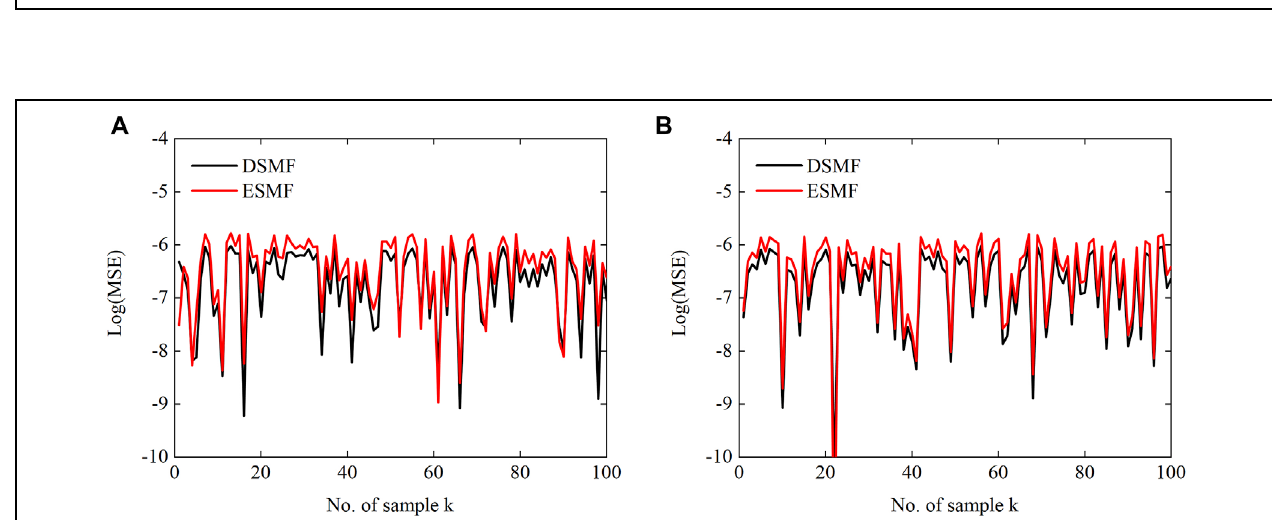
FIGURE 5 | The true and estimated values of a-phase at bus 4: (A) the real part of the voltage and (B) the imaginary part of the voltage.